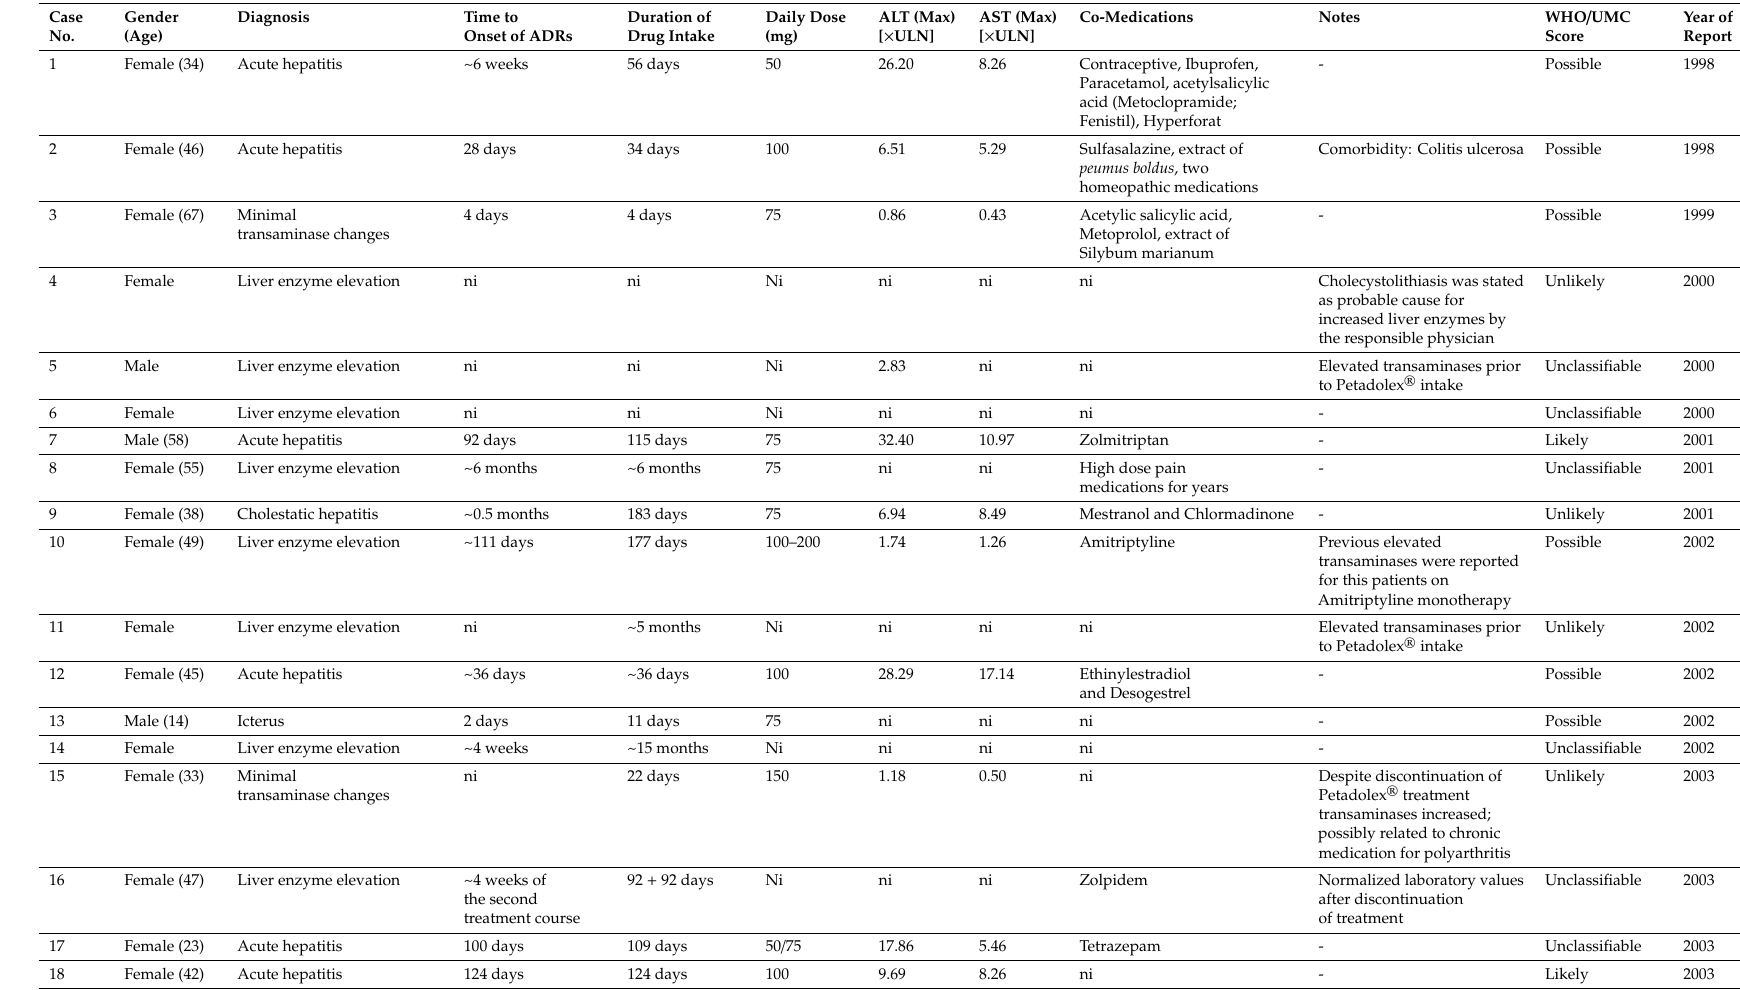
Table 1. Forty-eight spontaneous hepatobiliary ADR case reports in association with Petadolex ®